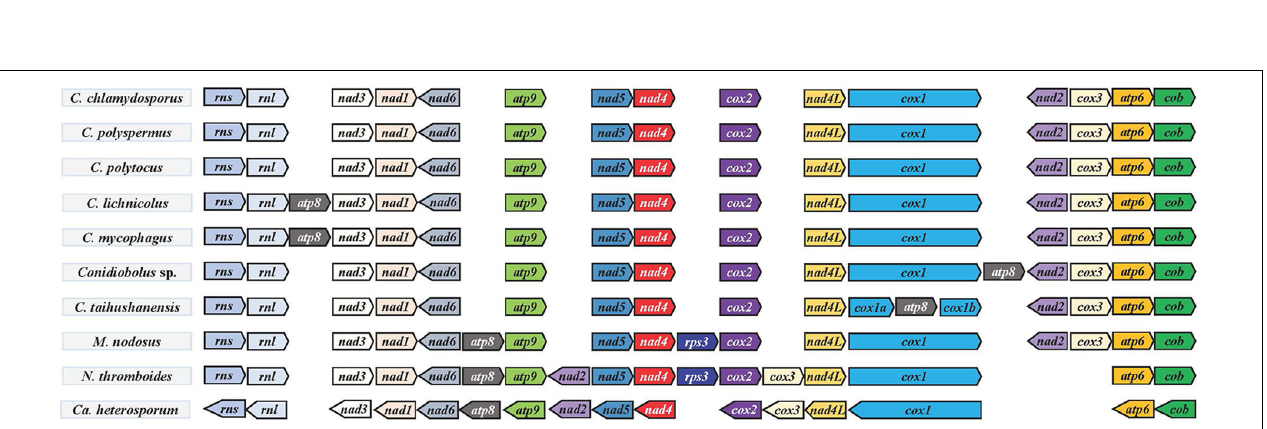
FIGURE 4 | Gene order in Conidiobolus s.s. mitogenomes and four related species. All species were adjusted to start with the gene rns . Genes on the forward and reverse strands were indicated by right and left arrows, respectively.